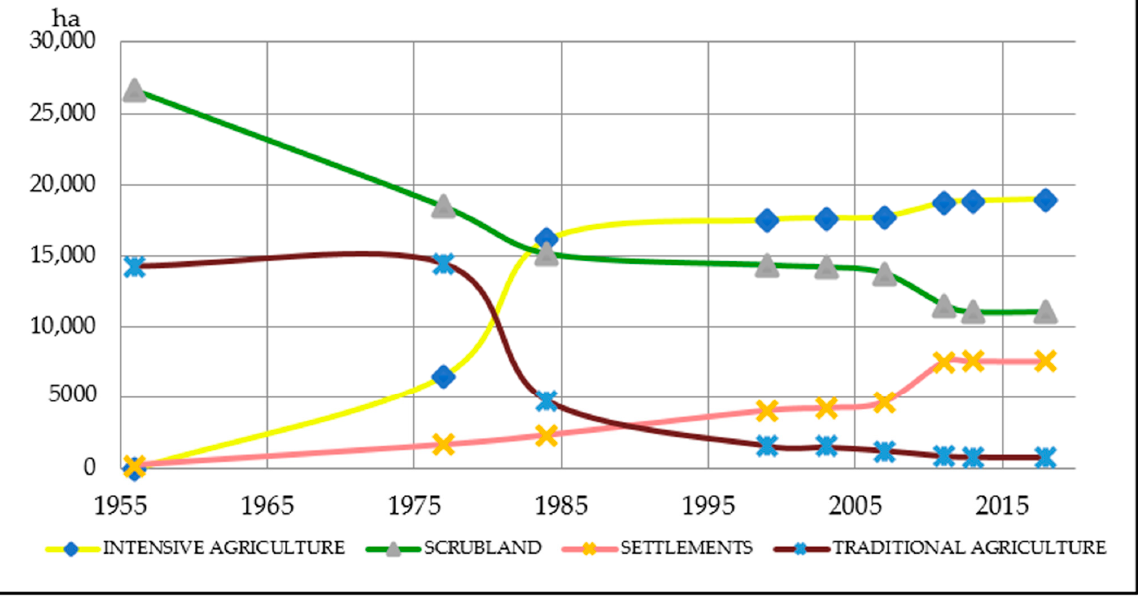
Figure 3. Evolution of intensive agriculture, scrubland, settlements, and traditional agriculture from 1956 to 2018.